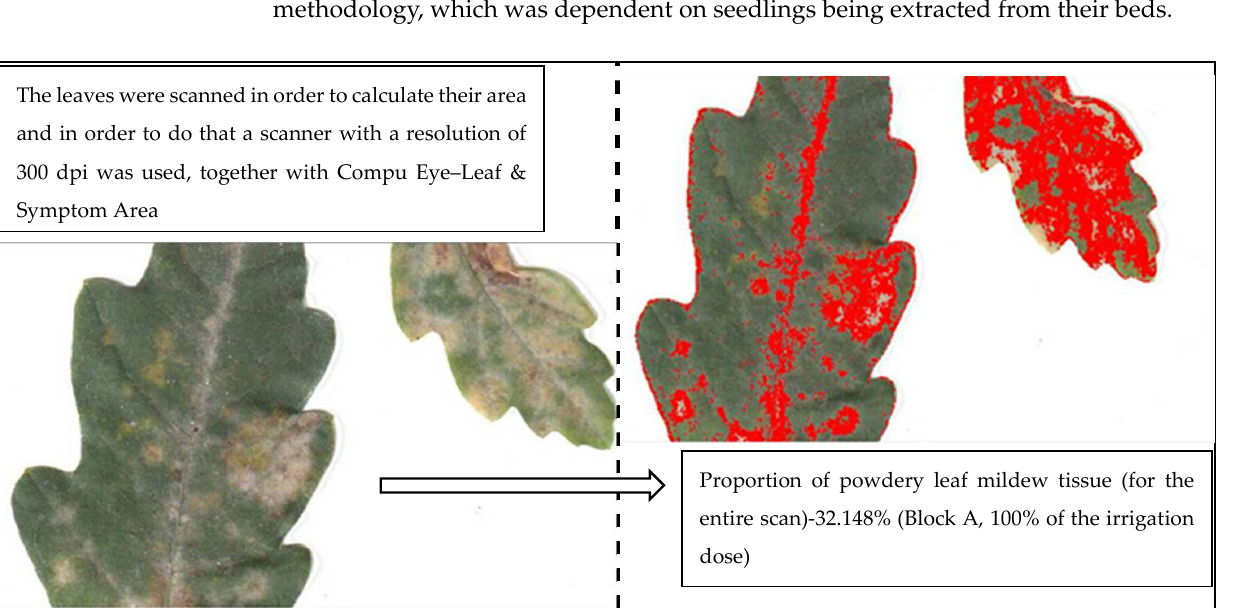
Figure 6. Determine the degree of infestation of scanned leaves with use Compu Eye, Leaf & Symptom Area.